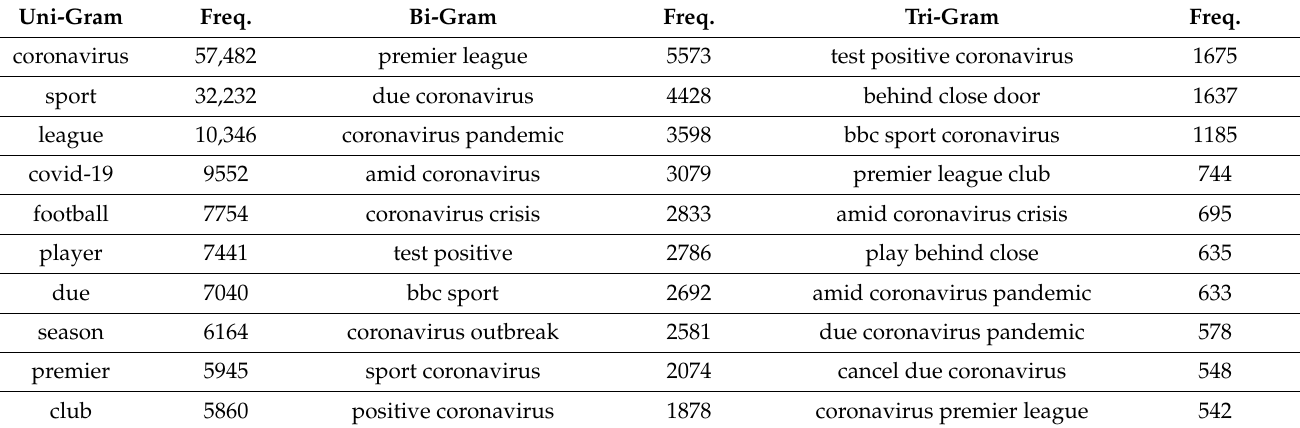
Table 2. The unigrams, bigrams, and trigrams that were used most in the tweets recovered. Uni-Gram Freq. Bi-Gram Freq. Tri-Gram